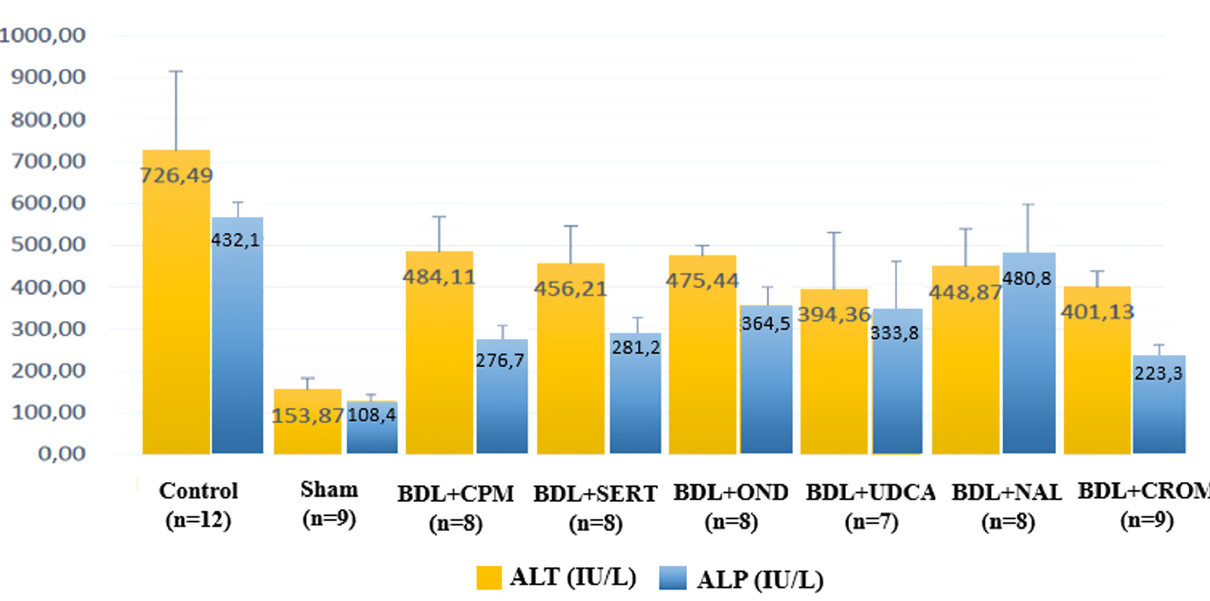
Figure 3. The ALT and ALP levels of all groups are depicted. ALT, alanine aminotransferase; ALP, alkaline phosphatase.